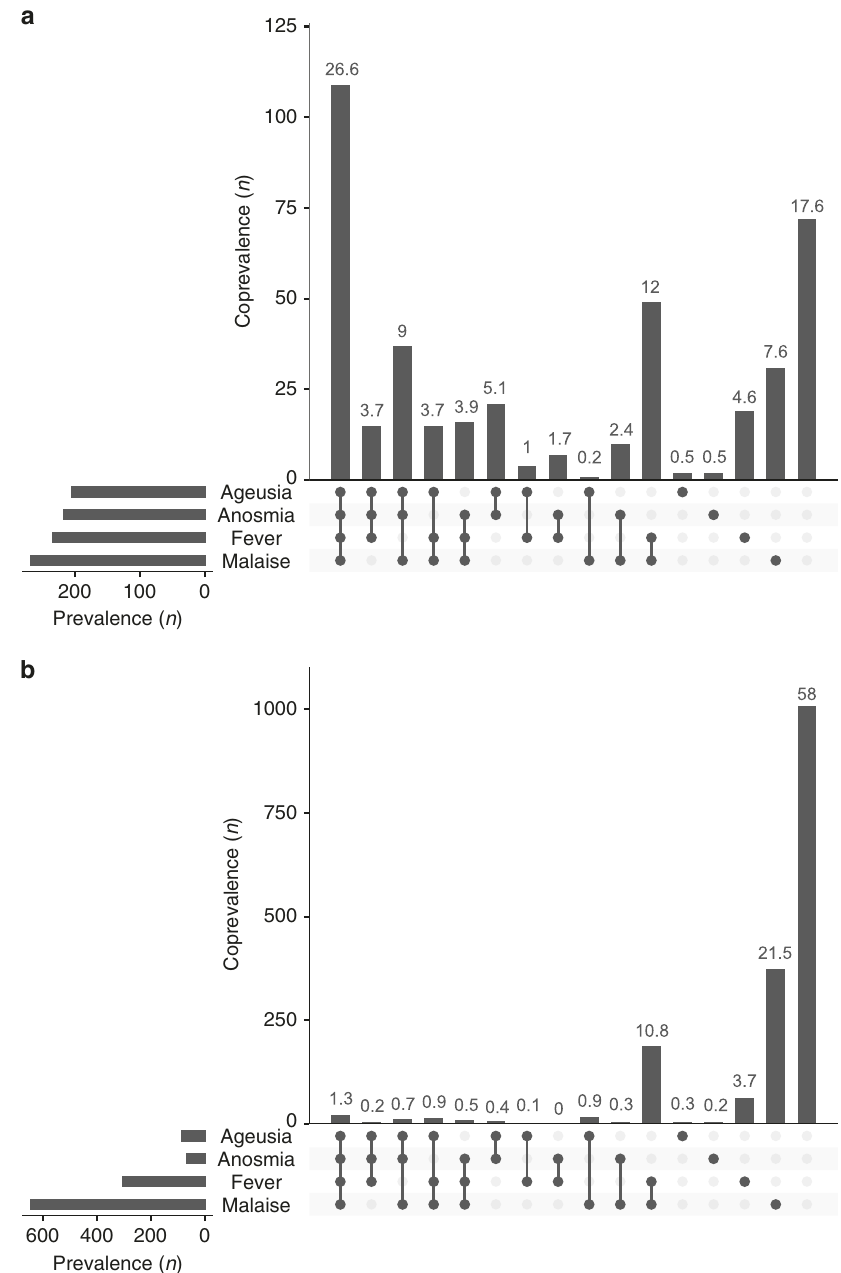
Fig. 1 Symptomatology. Symptomatology in seropositive ( a ; n = 410) and seronegative ( b , n = 1739) individuals. Horizontal bars to the left represent the total number of participants in each group reporting the speci fi cally denoted symptom. Vertical bars show the total number of participants in each group reporting symptoms symbolized with black dot(s) in the corresponding column. The percentage of participants reporting symptoms symbolized with black dot(s) in the corresponding column is presented above the bars. Source data are available as Source Data fi